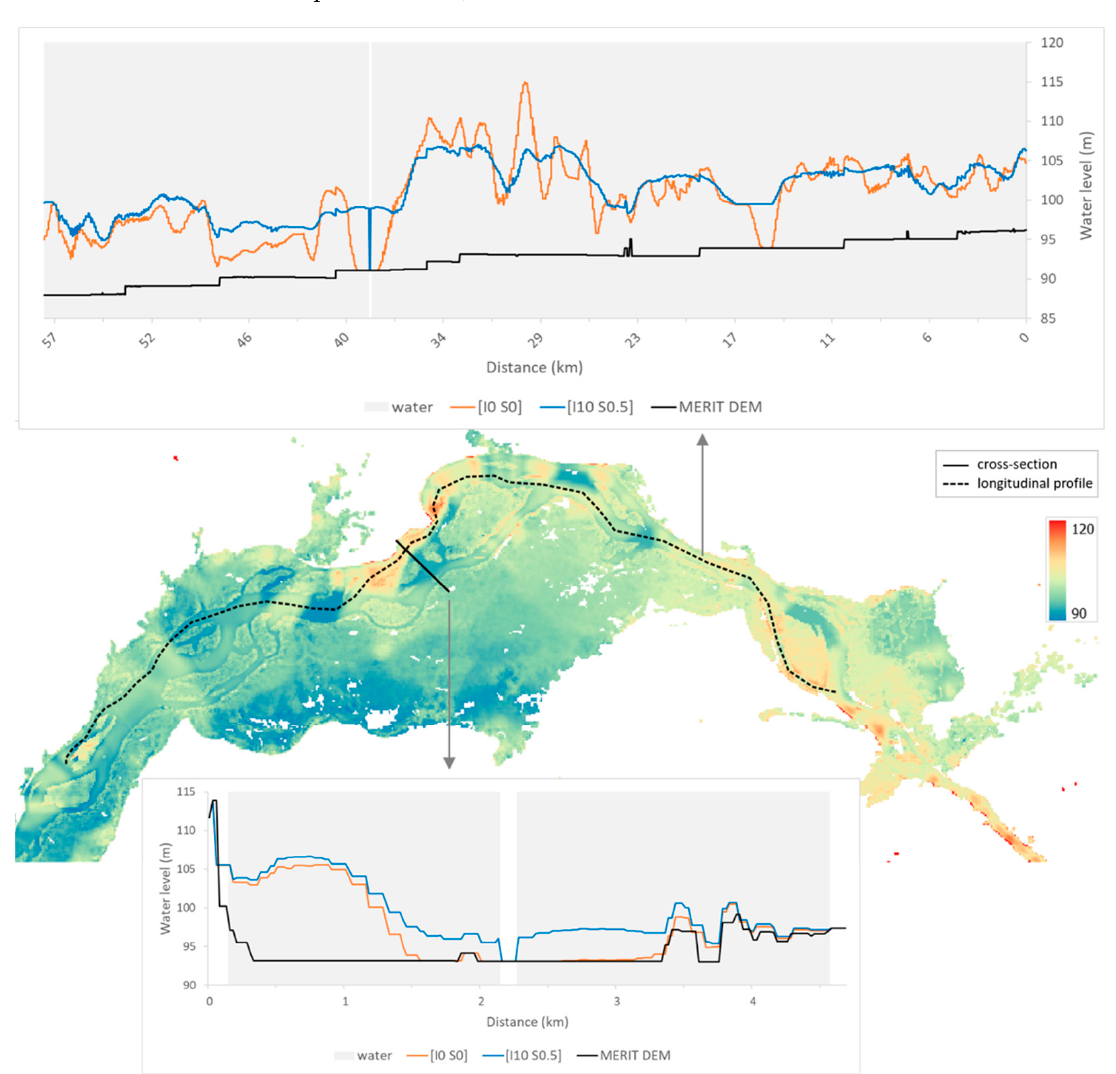
Figure 11. Longitudinal ( top ) and cross-section ( bottom ) profiles of the results of FwDET using MERIT DEM and flood map derived from Sentinel-1 imagery of July 16, 2019. The map shows water level results from FwDET2.1-GEE [I0 S0].